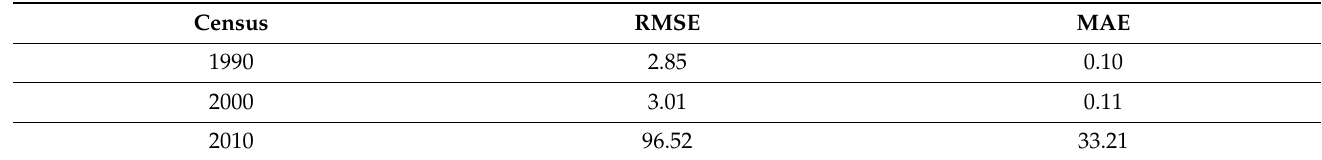
Table 2. Error assessment of IDM method (The values refer to the pixel size, 900 m 2